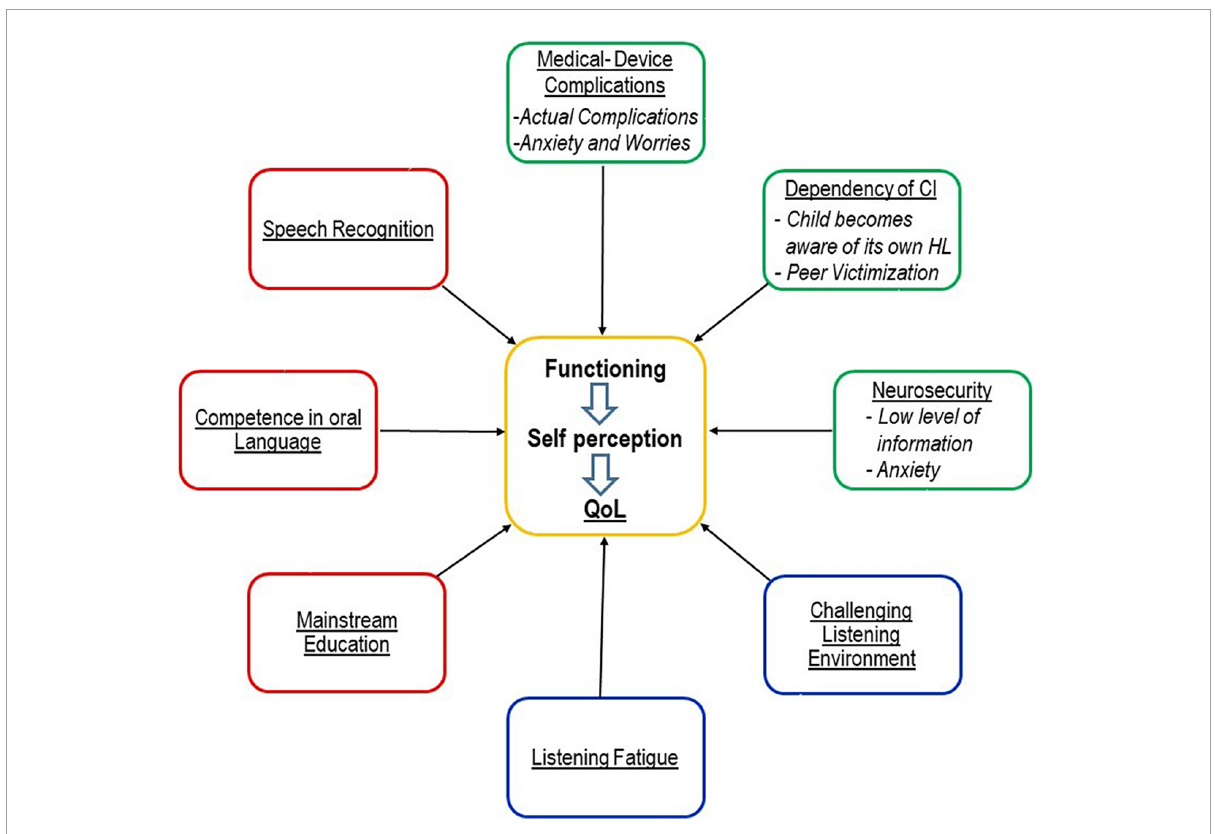
FIGURE2 Model illustrating CI-specific advantages and risks as possible influencing variables on QoL [following the model of Wilson and Cleary (1995)] of older children and adolescents with CI. Please note that this is a simplified illustration since possible associations and interactions between the variables are not shown and there is the assumption that the impact of variables can gain and lose weight over time. This possible dynamic was not illustrated in the graph; and individual characteristics, as well as socioeconomic and educational background, have also an impact on QoL but are not shown in the graph. Red: CI-specific benefit. Blue: Burden specific for hearing loss (Umansky et al., 2011; Rachakonda et al., 2014). Green: CI-specific